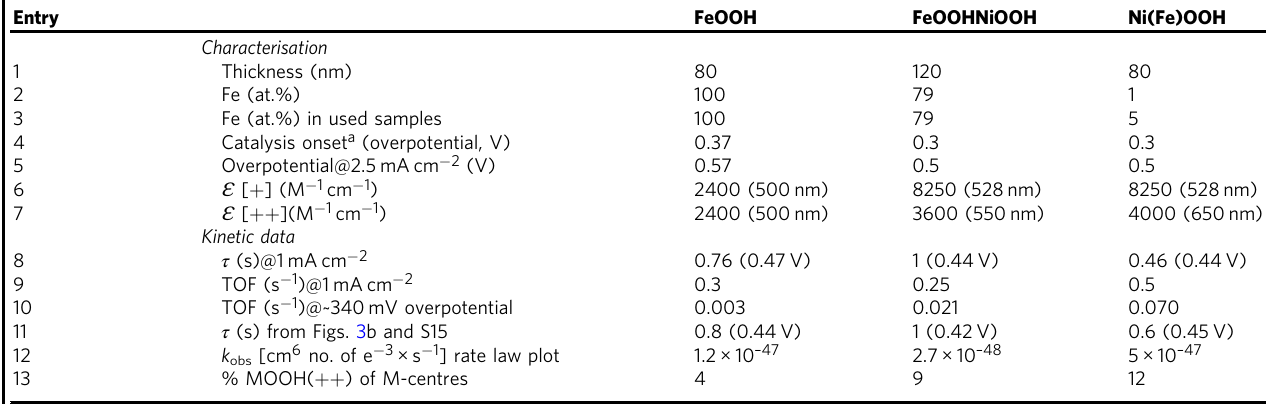
Table 1 Summary of data discussed in this